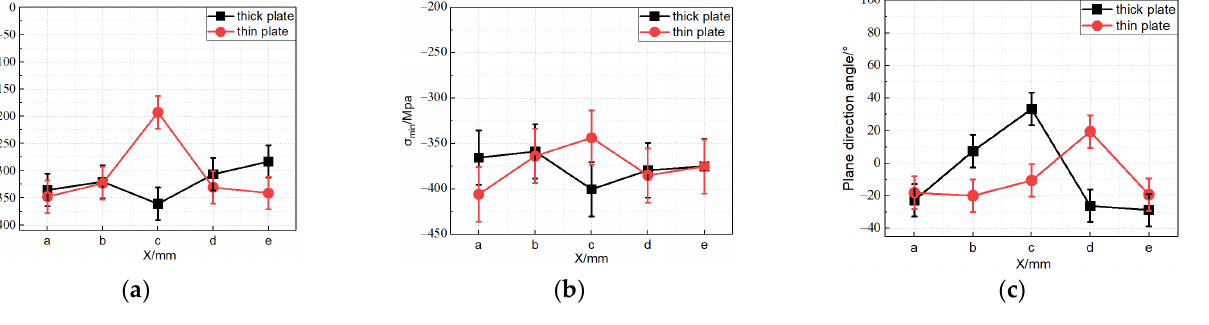
Figure 14. Comparison of the residual stress characteristics on the thin plate and thick plate samples at a laser power density of 2.77 GW/cm 2 : ( a ) Maximum residual principal stress distribution. ( b ) Minimum residual principal stress distribution. ( c ) Principal stress direction angular distribution.